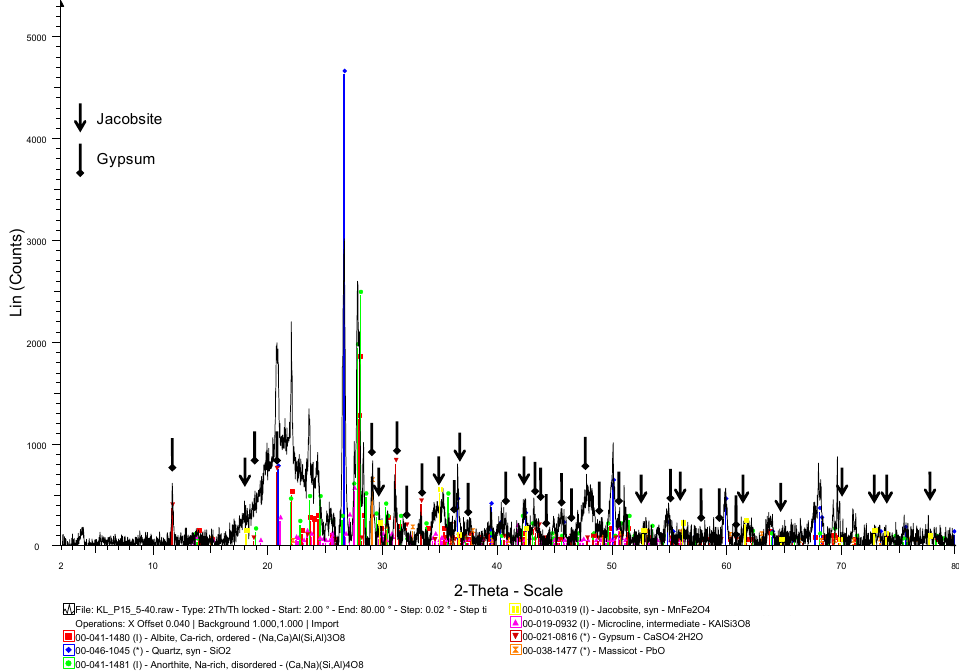
Figure 5. Representative X-ray diffraction (XRD) pattern for biologically produces solid precipitates collected at the end of sulfate reduction experiments (80 days). Peaks marked by arrows have been identified as Jacobsite and Gypsum. The formation of amorphous precipitates is shown as a bulking of the baseline (Black line). The vertical bar shows the scale of relative counts. Initial concentrations in batch reactors were As = 3.6 mg·L − 1 , Fe = 81 mg·L − 1 and SO 42 − = 4678 mg·L − 1 .